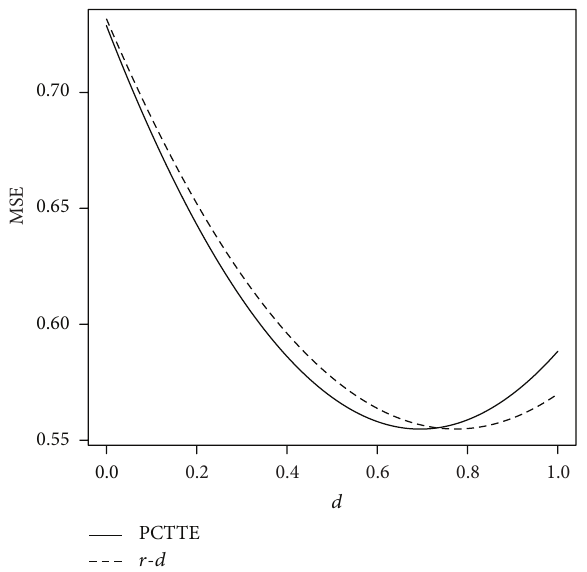
Figure 6: The MSE values of 𝑟 - 𝑑 class estimator and PCTTE when 𝑘 = 0.9 .